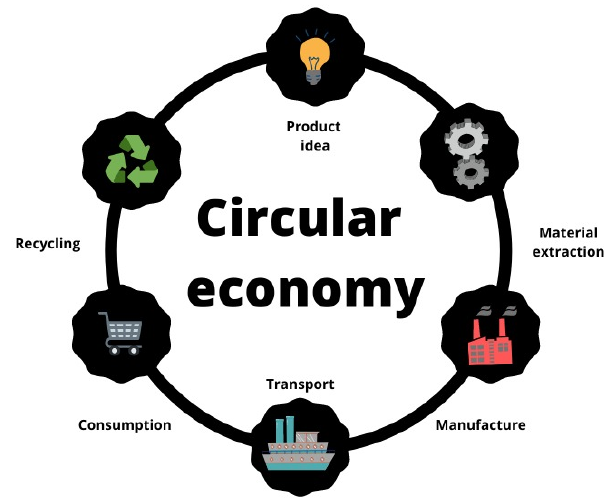
Figure 2. Circular economy.